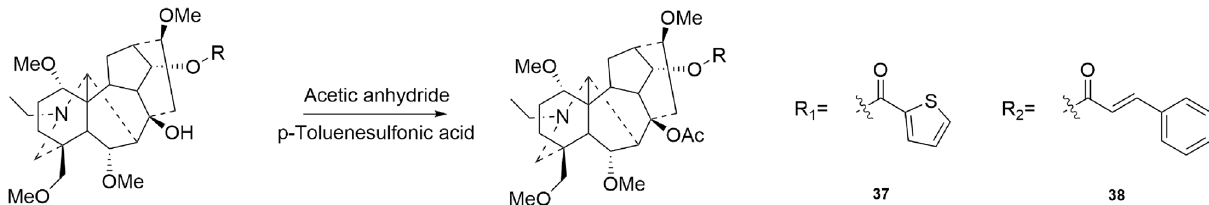
Figure 3. Synthetic route of target